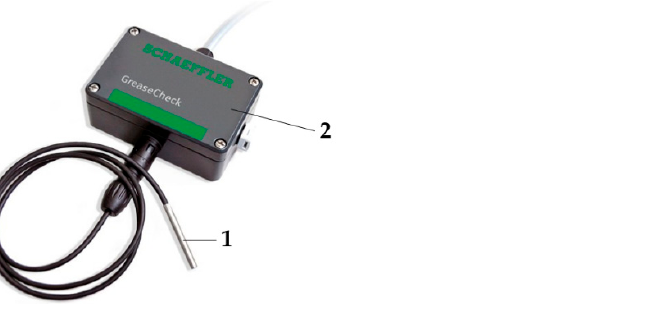
Figure 28. Grease sensor and electronic evaluation system, (1) Grease sensor; (2) Electronic evaluation system (Adapted from [205]).